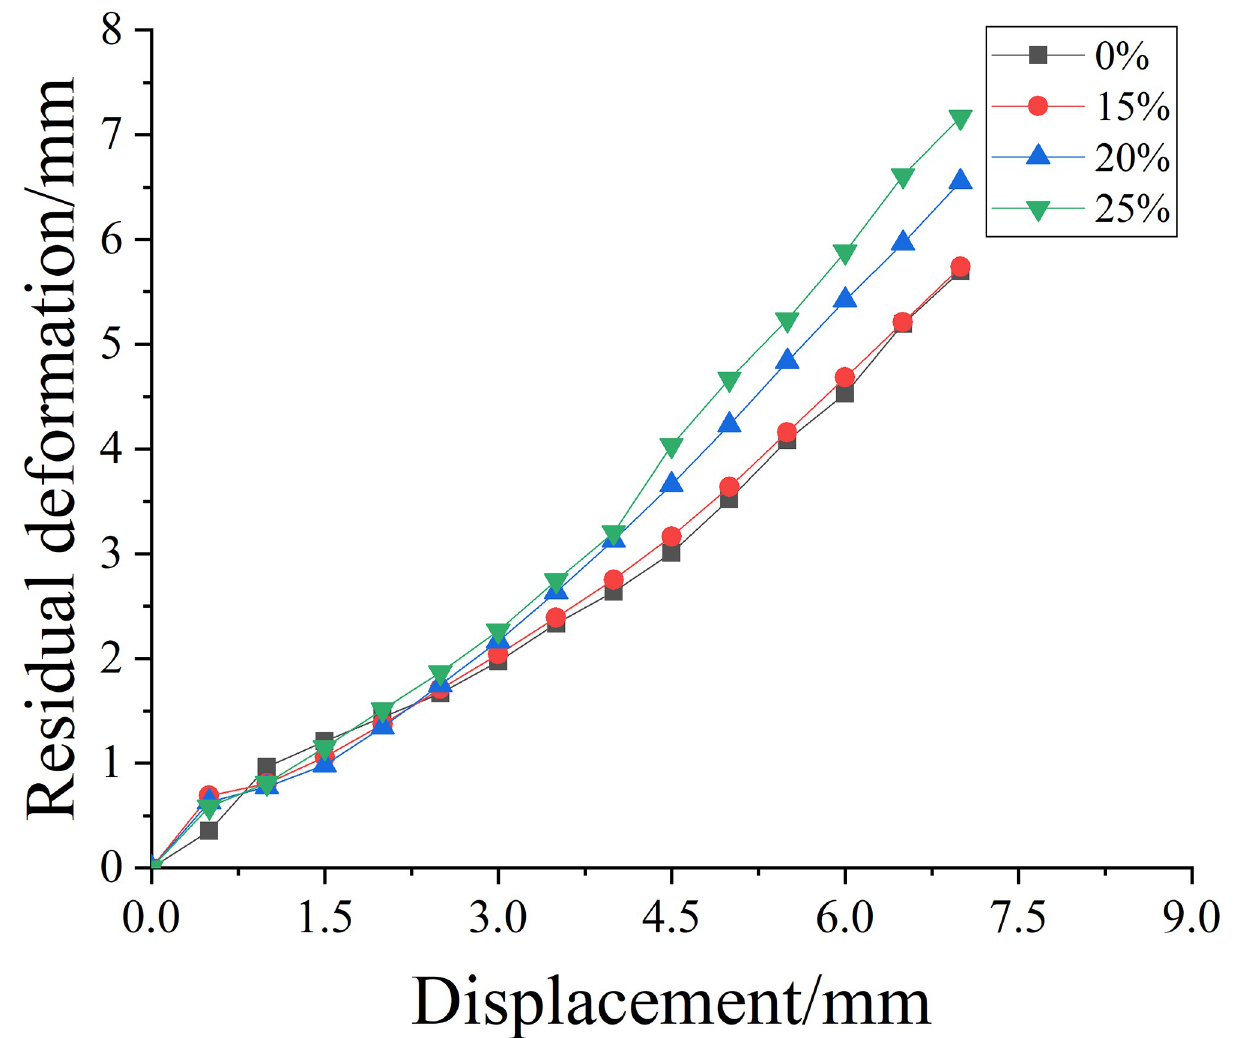
Fig 12. Residual deformation curves of reinforced concrete columns with different salt solution concentrations.